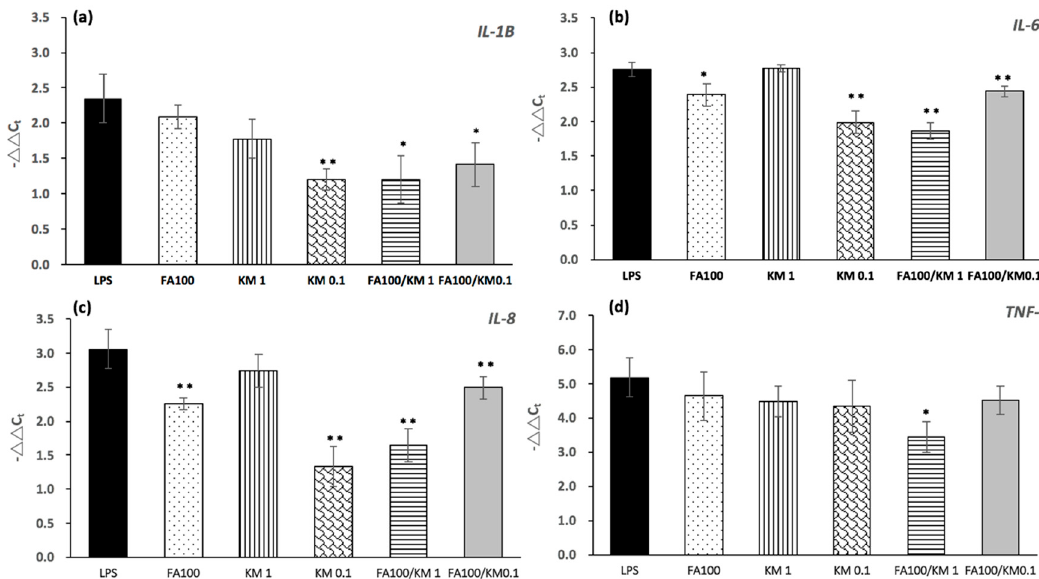
Figure 3. Gene expression of ( a ) IL-1B , ( b ) IL-6 , ( c ) IL-8 , and ( d ) TNF α in HCECs showing variations in LPS-induced inflammation (6 h) following various treatments. The control group consisted of cells left untreated with LPS. Results are displayed as the fold increase compared to the expression in normal HCECs. Statistical analysis was taken for each group in comparison with the LPS group ( n = 6, * p < 0.05, ** p < 0.01). LPS: lipopolysaccharide; FA100: 100 µM FA; KM1/KM0.1: 1/0.1 µM of KM;